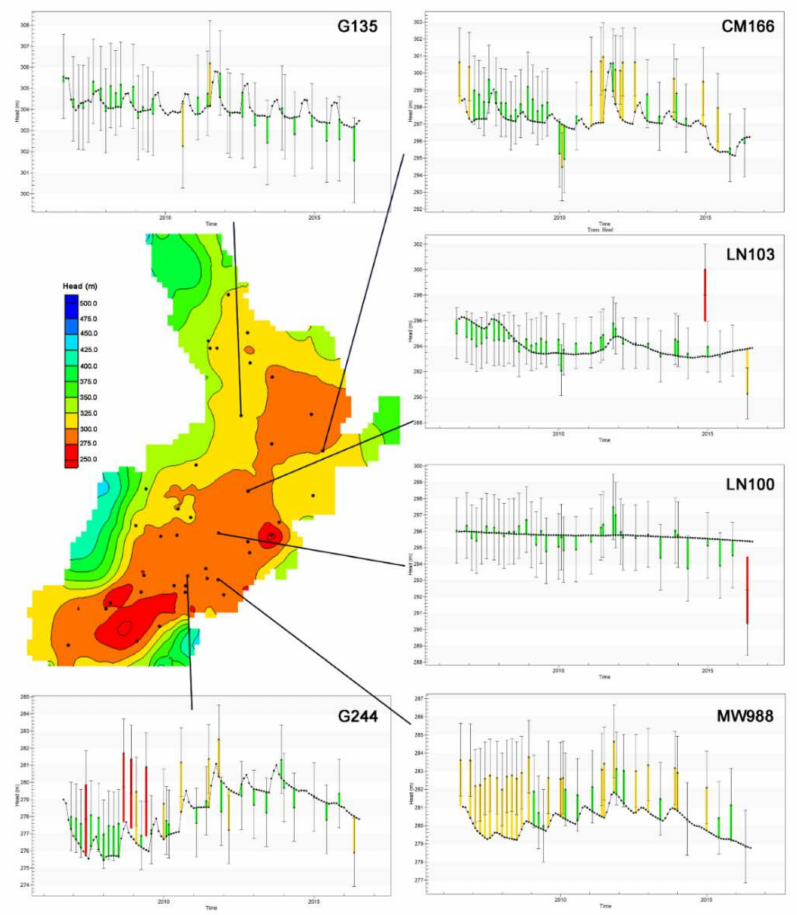
Figure 11. Examples of transient hydraulic heads between modeled and observed heads. Final parameters distributions (K, S s ) are illustrated in Figures 12 and 13 indicating that the Chiang Mai aquifer systems are highly heterogeneous. Figures 14 and 15 illustrate the recharge and evapotranspiration, which vary temporally from year to year, respectively. Zones of high recharge rates are located in the northern, eastern, and parts of southwestern areas of the basin. These areas should be reserved for recharge protection areas. The tran- sient model was investigated further to evaluate the effect of yearly precipitation variation on groundwater natural recharge. Based on the water budget analyses, it was confirmed that the values of natural recharge vary temporally and have a strong dependency on the precipitation pattern (see Figure 16), with a Pearson’s correlation coefficient of 0.79. In recent years, the overall precipitation has been declining significantly and so has the groundwater recharge. This is also confirmed by observed groundwater heads at several locations where groundwater table or potentiometric surface, though seasonally varying, are continuously